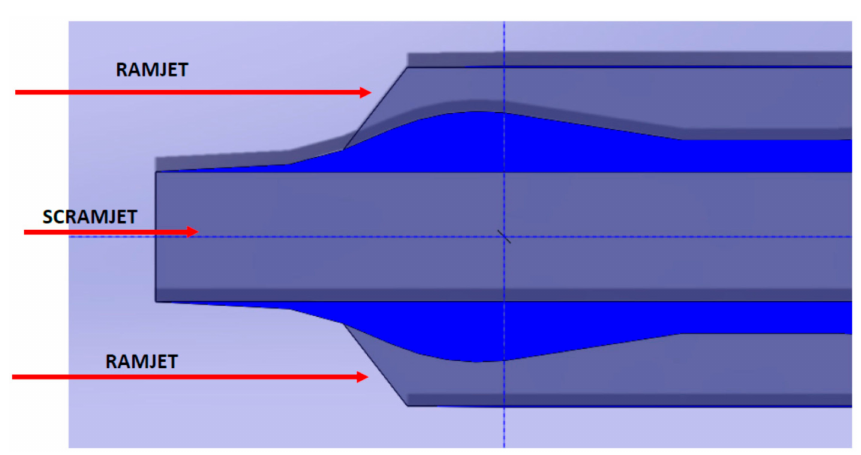
Figure 27. Top view of engine cross section.